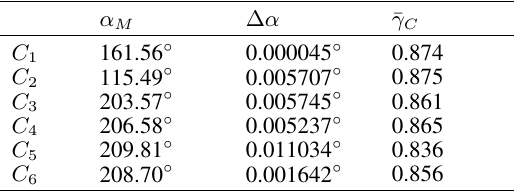
Table 2. List of coherence images: Master azimuth α M ; azimuth difference ∆ α ; local mean coherence level ¯ γ C